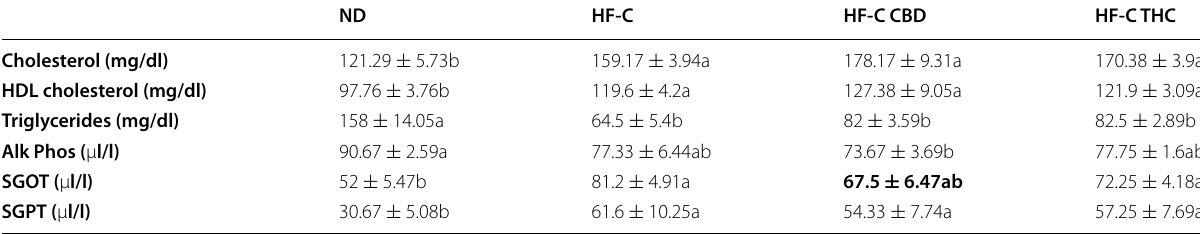
All values are expressed as mean